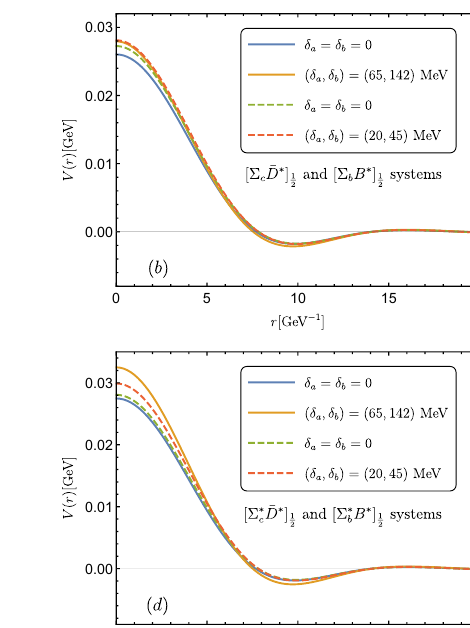
B ( (cid:3) ) systems. The unlisted systems b